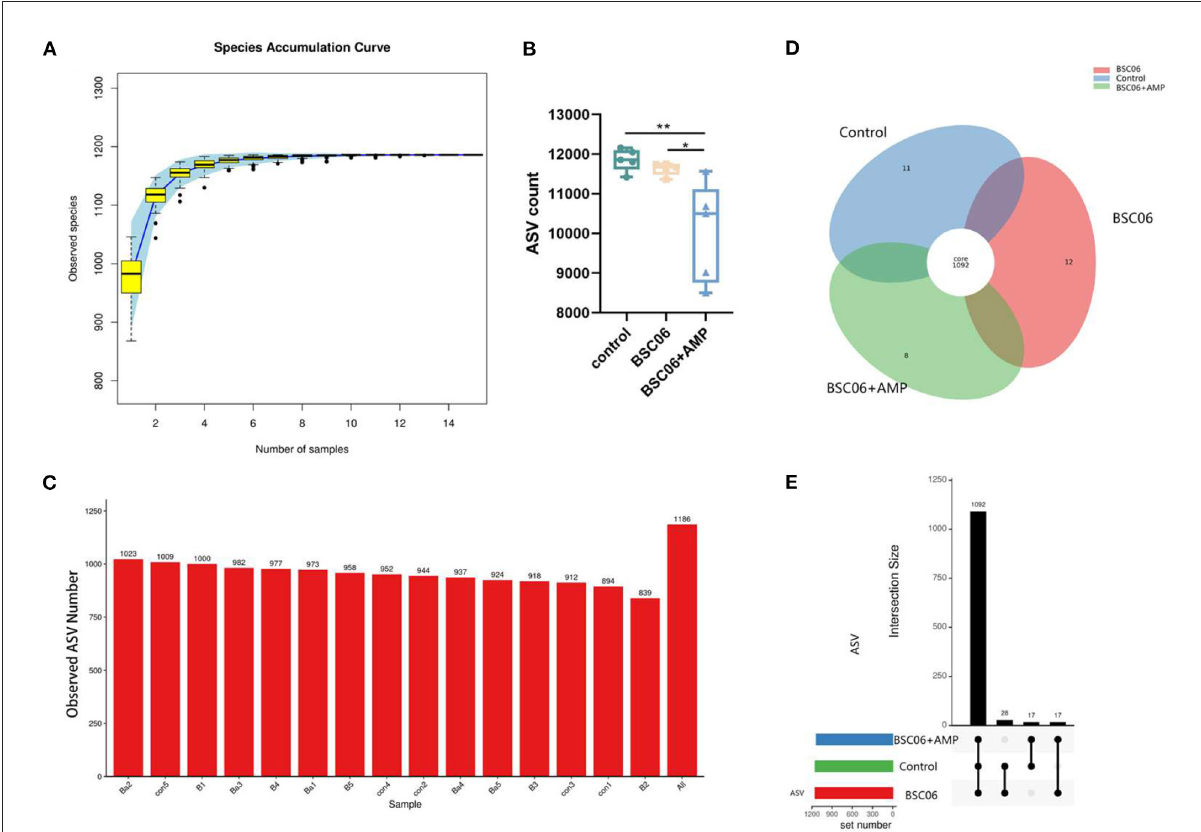
FIGURE4 Analysis of the number of species in cecum contents. (A) Species accumulation curve of samples number ( n = 5). (B) Number of detected ASVS counts. (C) Observed species number (con, control; B, Bacillus amyloliquefaciens SC06 ; Ba, Bacillus. amyloliquefaciens SC06 combined with antimicrobial peptide). (D,E) Describe the number of differential ASVS between groups. * P < 0.05, ** P <